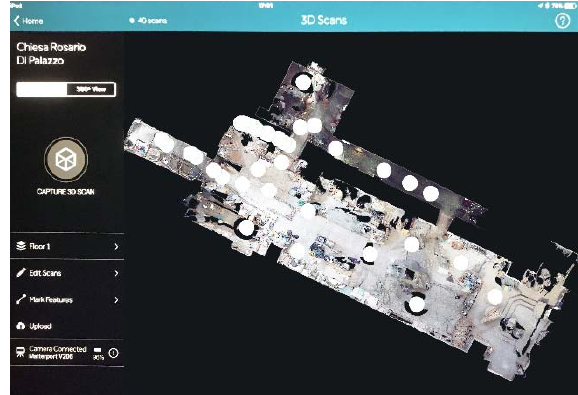
Figure 4: Displaying of three-dimensional data capture in Matterport Capture App.